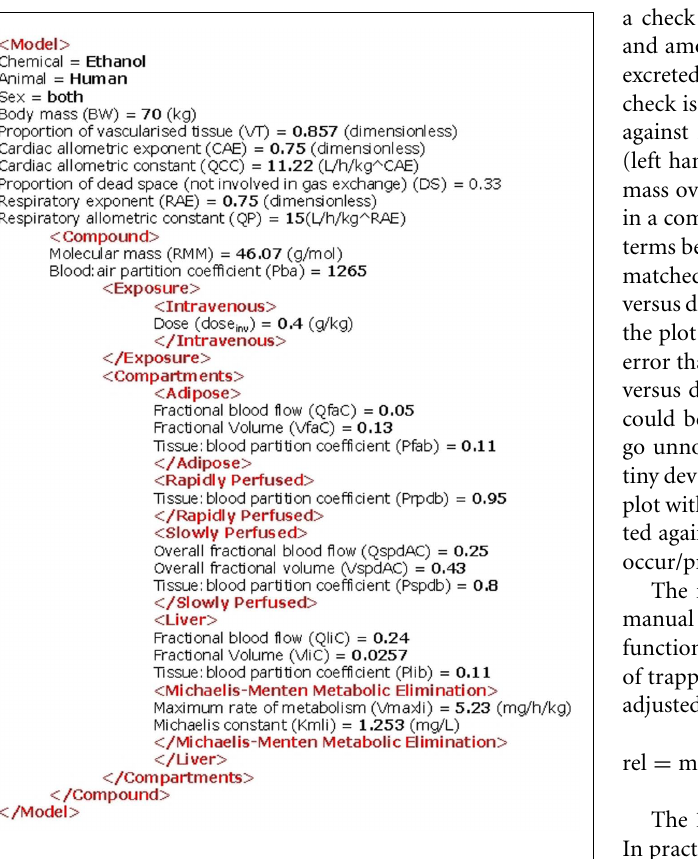
enclosed by the beginning and ending “elements,” < Model > and < /Model > ,respectively. The root model information is contained within this element. All exposure routes are contained within the beginning and ending exposure elements, < Exposure > and < /Exposure > . All compartments are contained within the begin- ning and ending compartment elements, < Compartments > and < /Compartments > . Compartment specific information such as partition coefficients, fractional blood flow and mass, and meta- bolic rate constants are contained within the beginning and ending elements of a specific compartment, e.g., < Liver > and < /Liver >